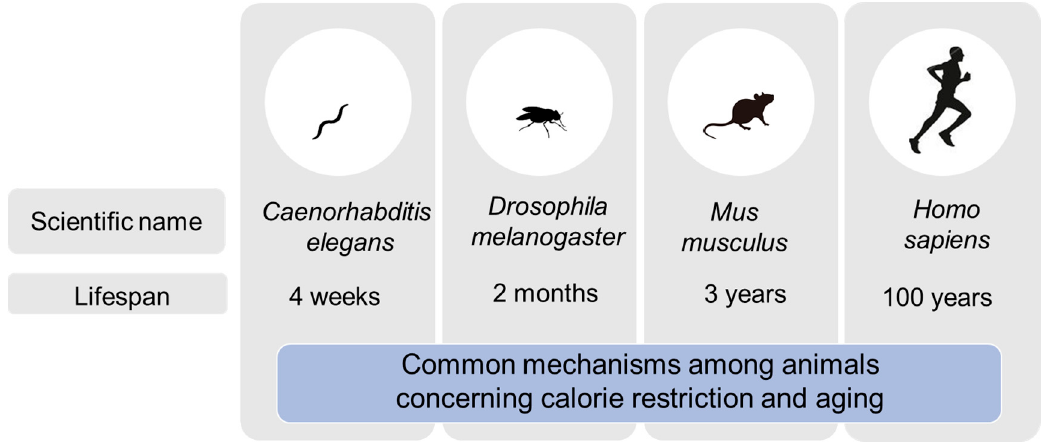
Figure 1. Experimental animal models.